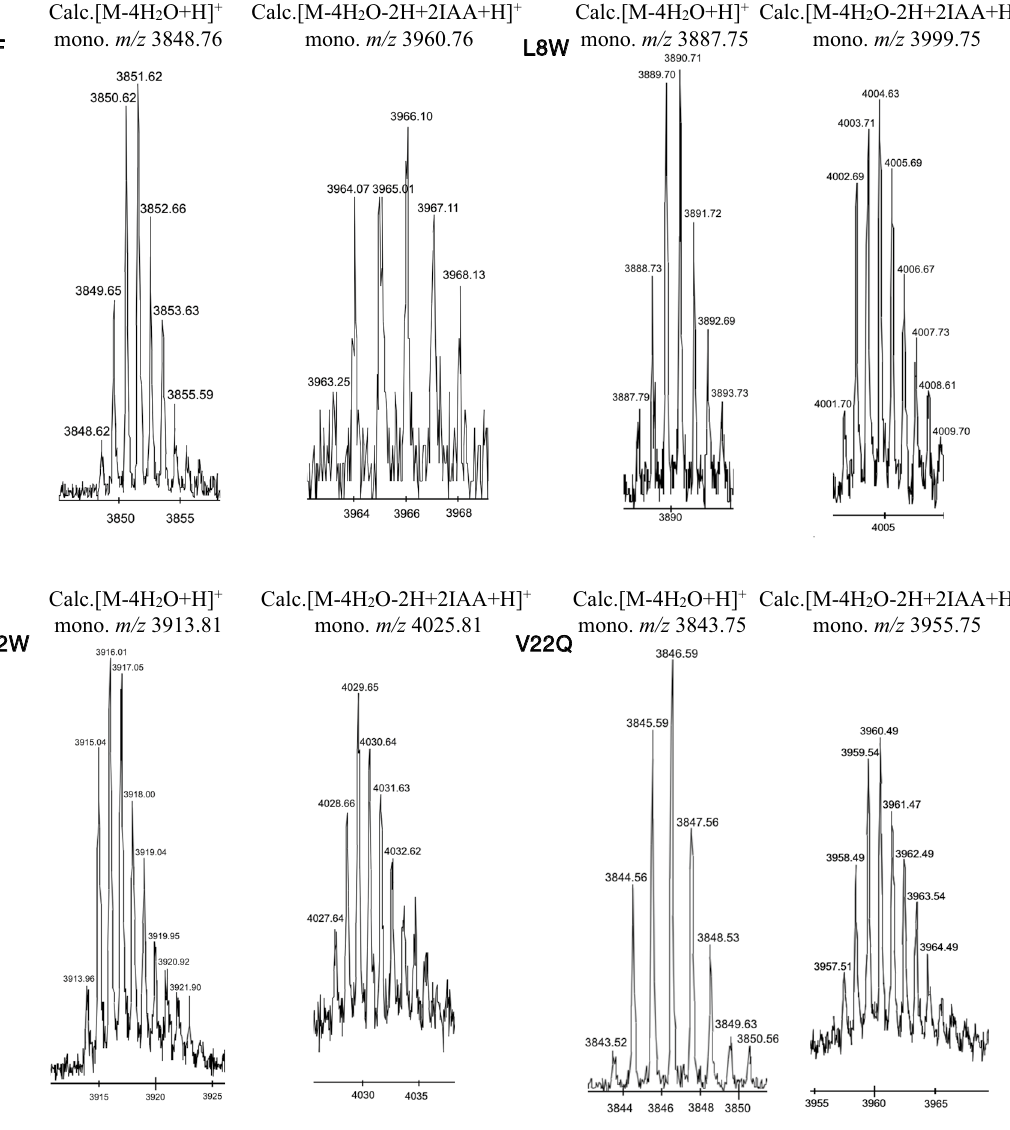
Fig. 7 MALDI-TOF MS of endoproteinase GluC treated Rosα after TCEP only and after TCEP represents the calculated and observed mass of the respective species of each variant